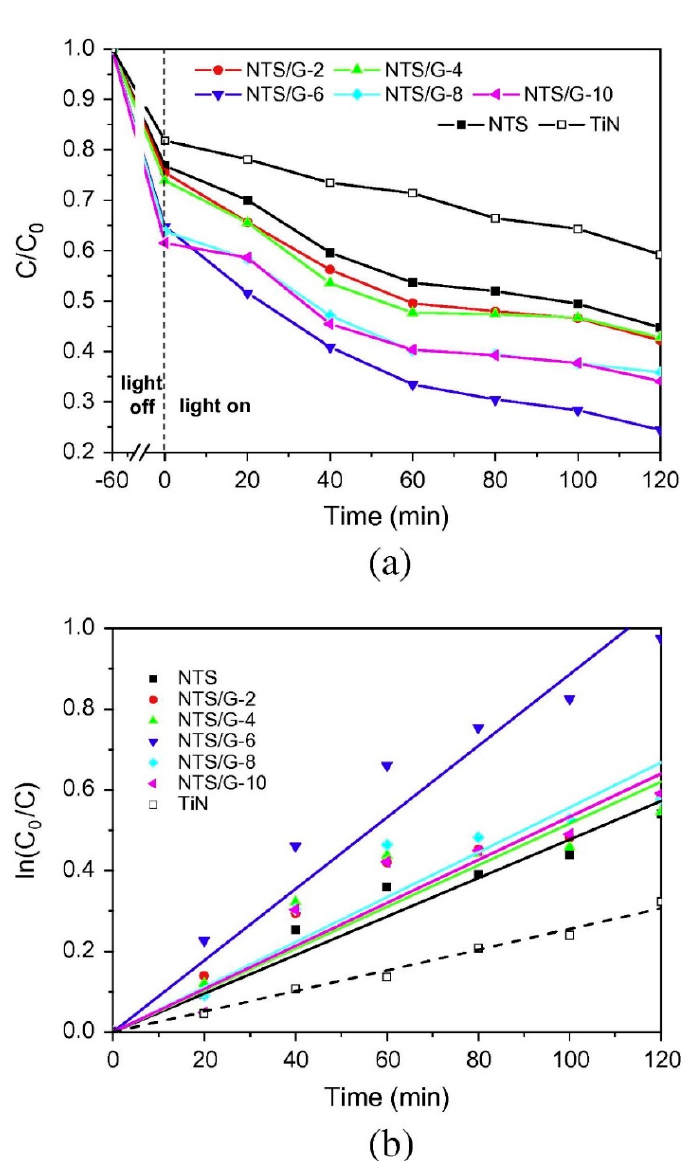
Figure 28. ( a ) Photodegradation of MB over TiO 2 /G nanocomposites with different amounts of G under visible light illumination, and ( b ) pseudo-first order reaction kinetics of MB photodecomposition. Reprinted with permission from reference [95]. Copyright 2014 Elsevier.